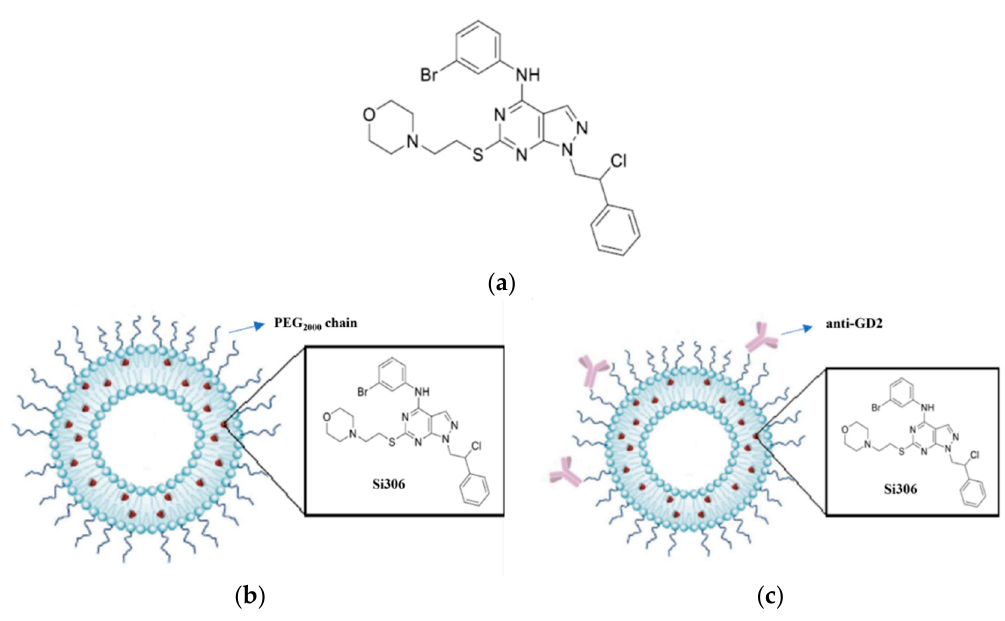
Figure 1. Development of Si306-loaded, untargeted and GD2-targeted pegylated stealth liposomes. ( a ) Chemical structure of Si306; schematic representation of ( b ) LP[Si306] and ( c ) GD2-LP[Si306]. As a potent inhibitor of c-Src, Si306 was found to induce apoptosis and to reduce